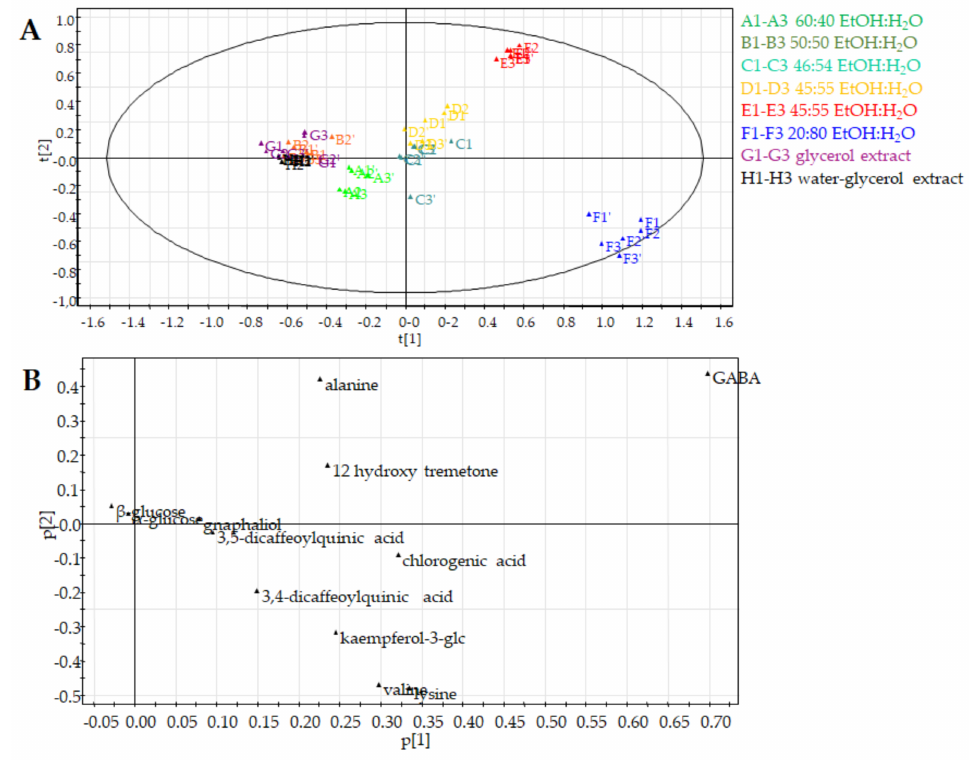
Figure 5. Principal component analysis of H. italicum derived food supplements ( A : 60:40; B : 50:50; C : 46:54; D and E : 45:55; F : 20:80 EtOH-H 2 O extracts; G : glycerol extract; H : water-glycerol extract) obtained by targeted analysis. ( A ) PCA score scatter plot; ( B ) PCA loading